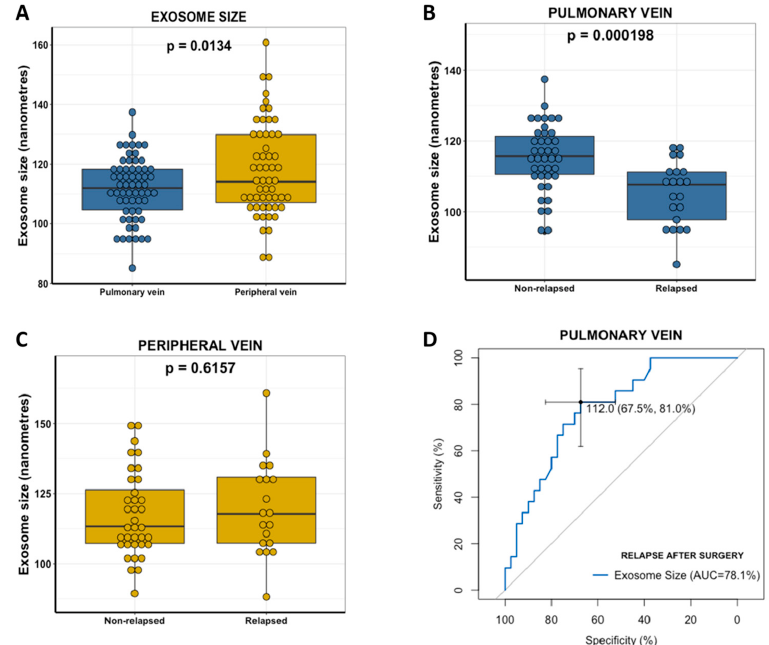
Figure 2. The relationship between exosomal size and relapse after surgery in NSCLC patients. ( A ) Boxplot showing exosome size distribution (size mode) in pulmonary and peripheral vein in NSCLC patients. ( B ) Boxplot showing pulmonary vein exosomal size in relapsed and non-relapsed NSCLC patients. ( C ) Boxplot showing peripheral vein exosomal size in relapsed and non-relapsed NSCLC patients. ( D ) ROC curve analysis of pulmonary vein exosomal size values predicting